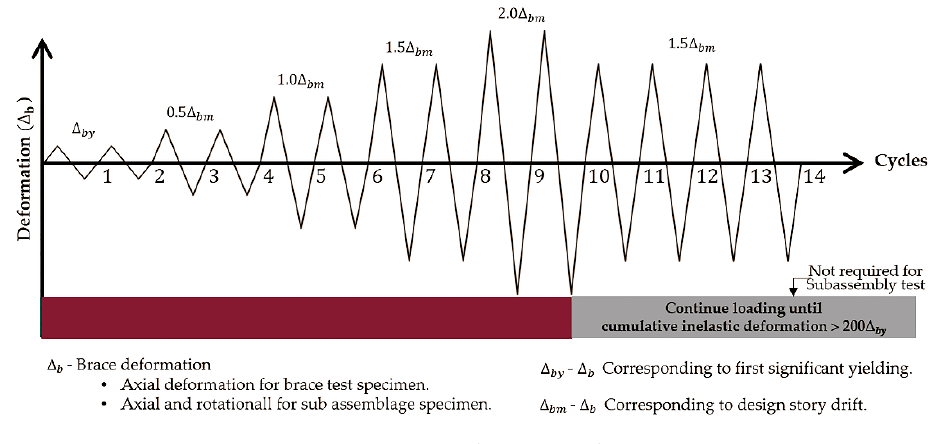
Figure 4. Loading Figure 4. Loading protocol. Figure 4. Loading protocol.